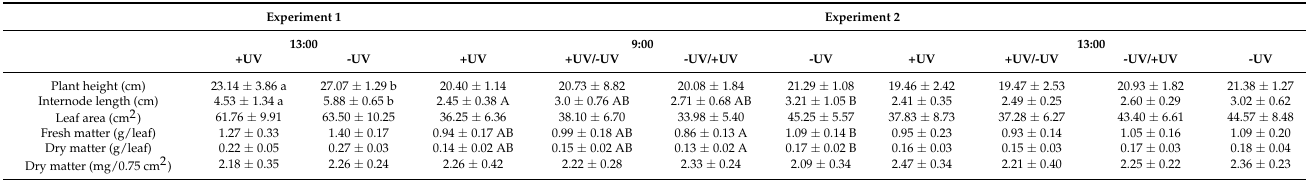
Table 1. Morphological parameters of okra plants grown under different UV conditions in Experiment 1 (targeting diurnal rhythm) and Experiment 2 (targeting changes in diurnal rhythm due to transfer to the opposite UV condition). These parameters were presented at 13:00 CDT (afternoon) for Experiment 1, and at 9:00 CDT (morning) and 13:00 CDT (afternoon) for Experiment 2. Different letters represent significant differences between the UV conditions at p ≤ 0.05. Experiment1